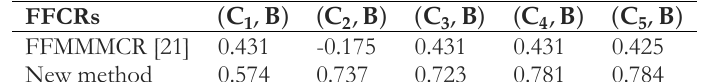
Table 8. Comparison for the FFCRs for problem 2.